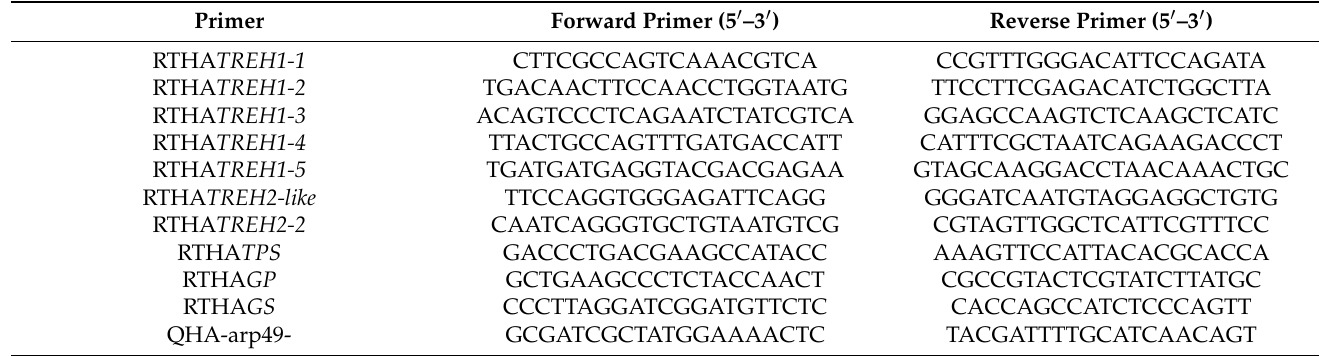
Table 1. Primers used for qRT-PCR determination of trehalose, glycogen, and TPS genes.